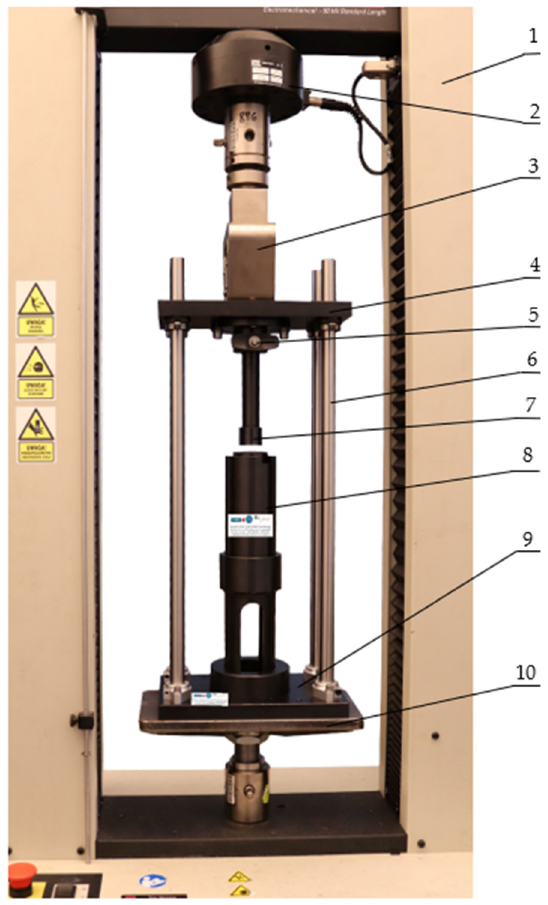
Figure 3. The stand for the testing of the elasticity modulus of dry ice as a function of density: 1. The MTS machine, 2. Machine sensor, 3. Machine grip, 4. Upper plate, 5. Pin, 6. Guide assembly, 7. Piston, 8. Compacting sleeve assembly, 9. Lower plate, 10. Machine base.